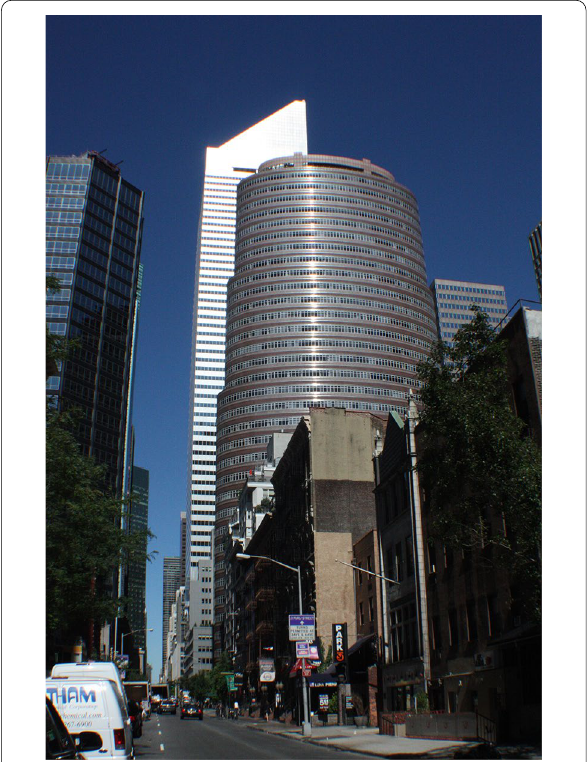
Fig. 14 The Lipstick Building in New York looks like